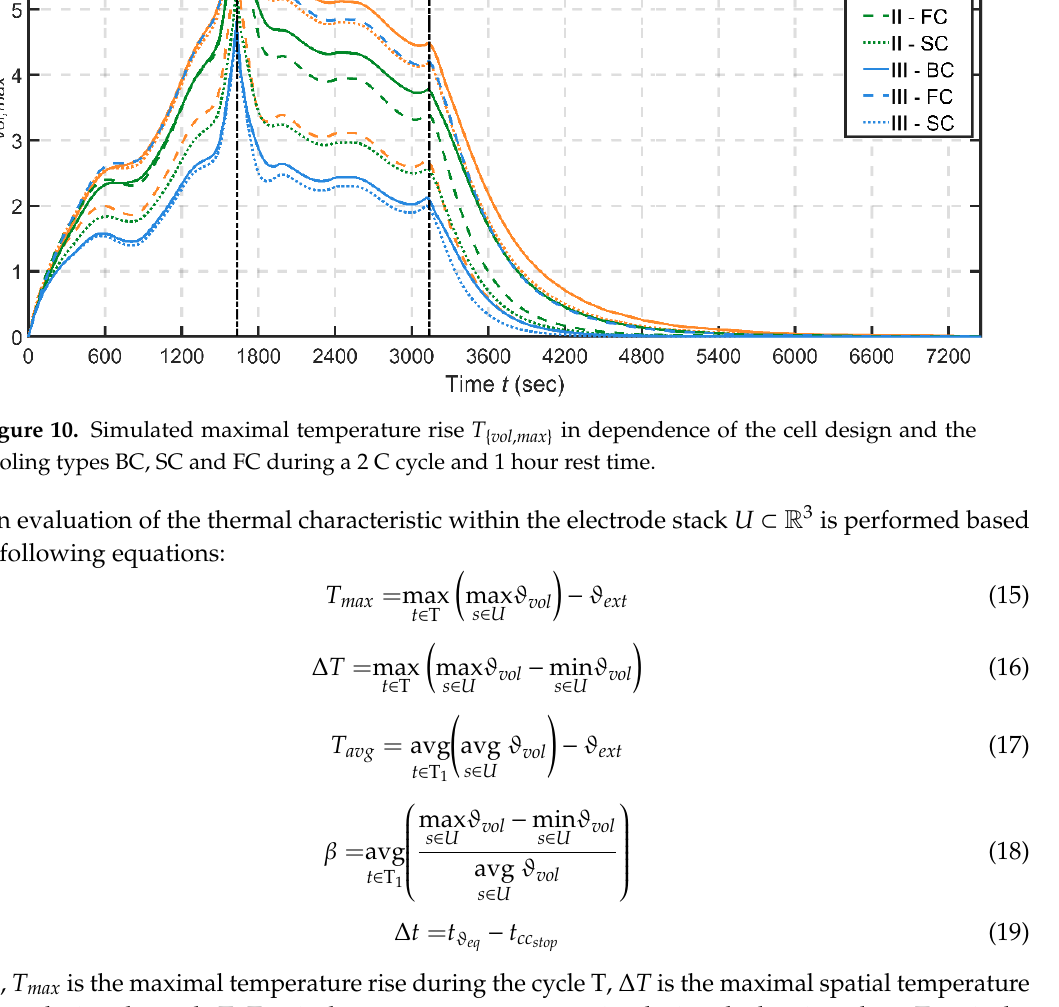
Table 2. Rating criteria and associated thresholds for the model study comparison.* 1